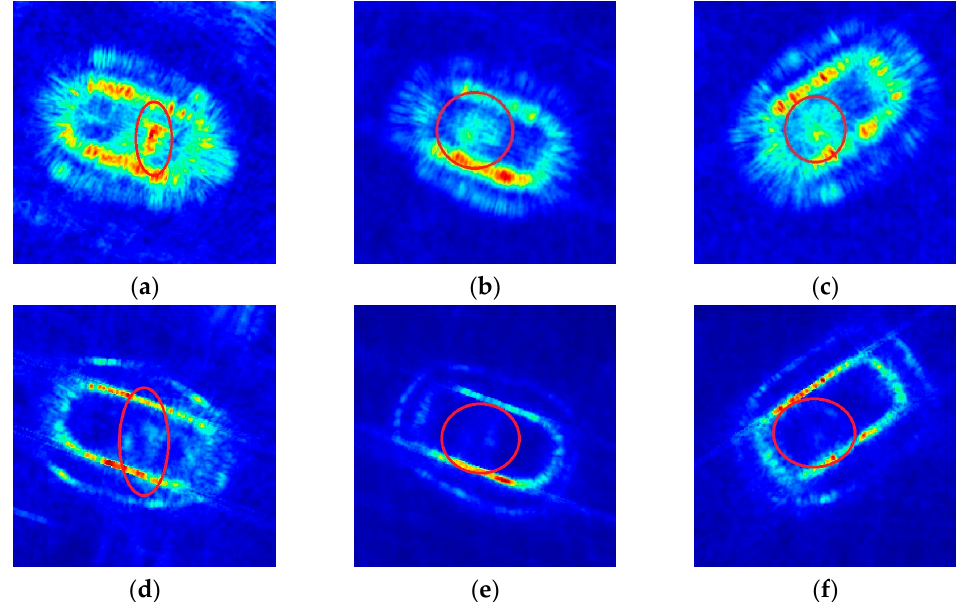
Figure 1. Example of imaging results of different models of vehicle targets in the Gotcha dataset by contour thinning imaging. ( a – c ) are images obtained by backprojection algorithm. ( d – f ) are images obtained by contour thinning algorithm. Three models of vehicle targets are used for imaging comparison: ( a , d ) Model Chevrolet Impala LT; ( b , e ) Model Mitsubishi Galant ES; ( c , f ) Model Toyota Highlander. Figure 2 is a schematic of CSAR imaging. The missing details in the contour thinning image correspond to the high reflection parts of the front or rear of the vehicle, as shown in the left image in Figure 2. Obviously, not all vehicles have the same highly reflective contour in front or rear. Therefore, the loss of this part is likely to reduce the recognition of vehicle targets. The first task of this paper is to restore this missing part and compensate for it in the contour thinning image.